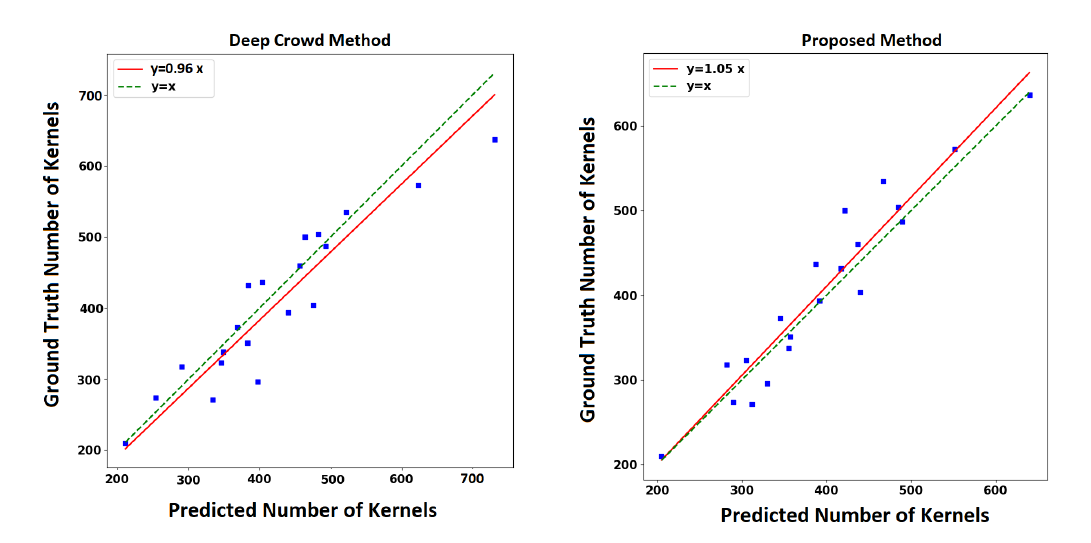
Figure 9. The left and right plots show the predicted number of kernels versus ground truth number of kernels for the Deep Crowd method and proposed method,